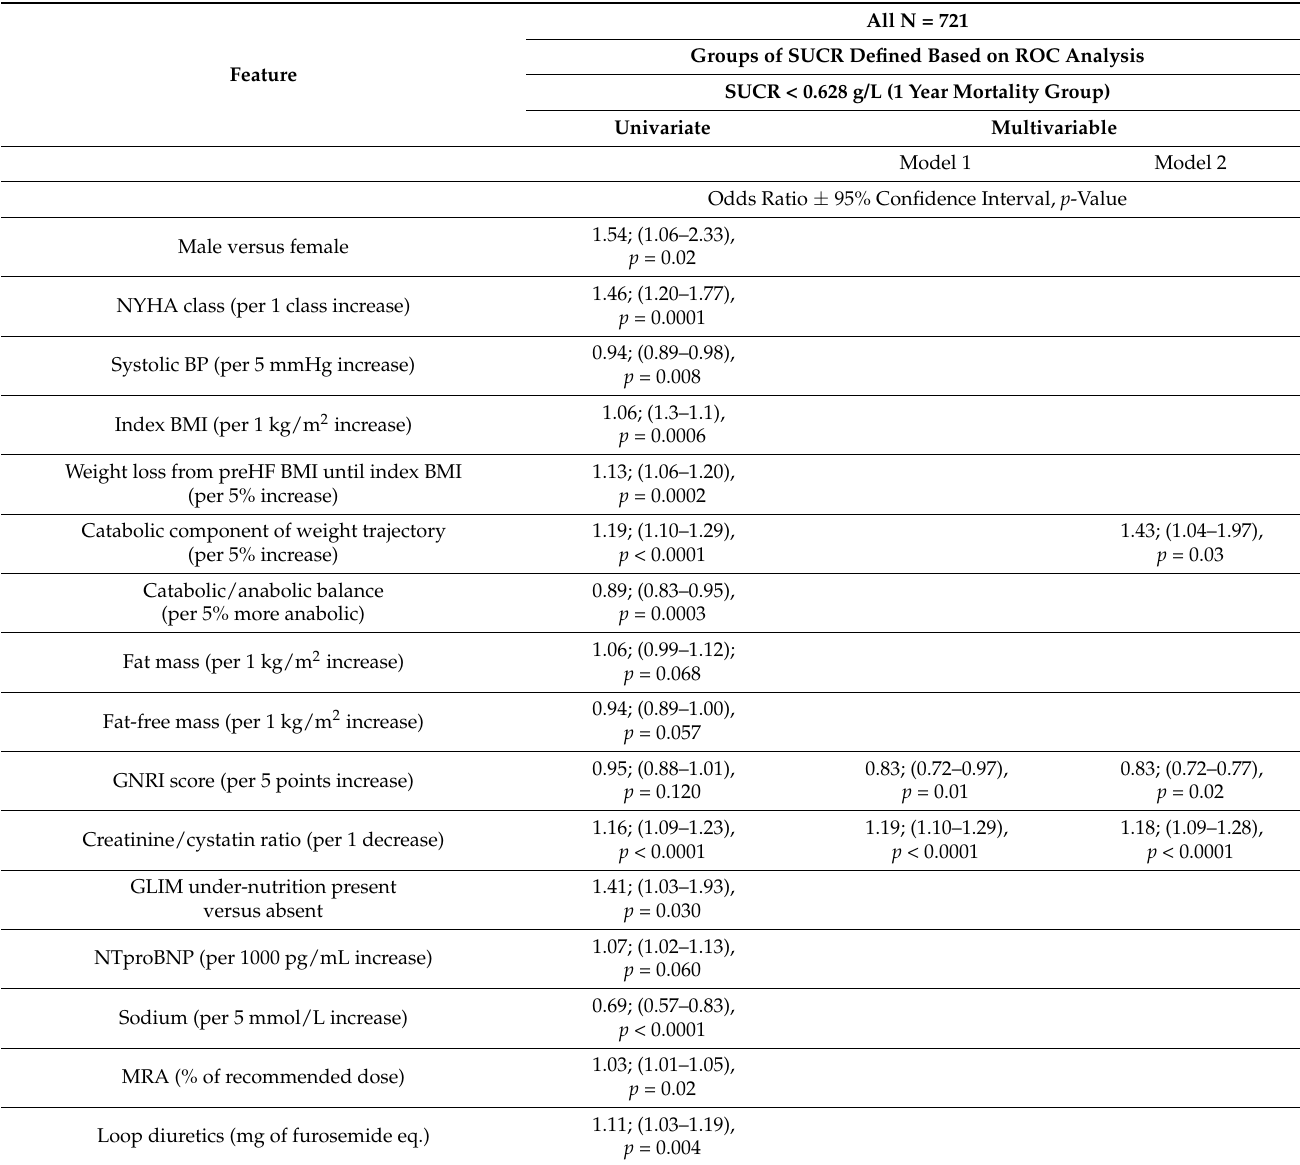
Legend (Table 3): Model 1—variables included in the multivariable model: gender (categorical), NYHA class (continues), systolic blood pressure, Index BMI, fat mass, GNRI score (continues), GLIM (categorical), NTproBNP, creatinine/cystatin C ratio, sodium, diabetes (categorical), % recommended MRA, and loop diuretics. Model 2—variables included in the multivariable model: gender (categorical), NYHA class (continues), systolic blood pressure, Index BMI, catabolic component of weight trajectory, % weight loss, catabolic/anabolic balance, fat mass, fat-free mass, GNRI score (continuous), NTproBNP, creatinine/cystatin C ratio, sodium, diabetes (categorical), % recommended MRA, and loop